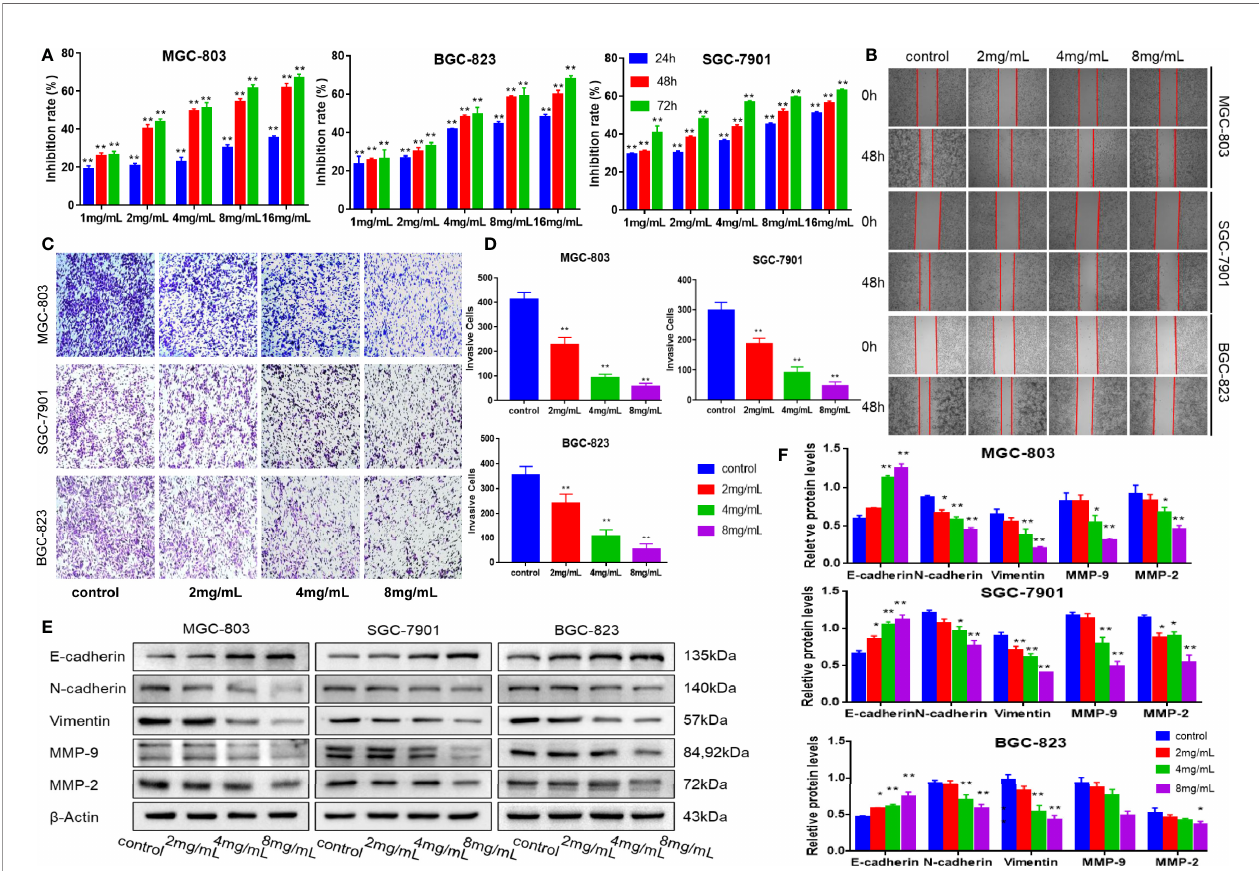
FIGURE 1 | mJPYZ inhibited the proliferation, migration and invasion of gastric cancer cells in vitro . (A) Viability of cancer cells interfered by mJPYZ was determined using the MTT assay. mJPYZ inhibited the GC cells proliferation in a dose- and time-dependent manner. (B) Migration of gastric cancer cells were detected by wound healing assay. The cell migration ability was decreased after mJPYZ treatment, and was positively correlated with the concentration of mJPYZ. (C, D) Invasion of gastric cancer cells were detected by Transwell invasion assay. The cell invasion ability was decreased after mJPYZ treatment, and was positively correlated with the concentration of mJPYZ. (E, F) Western blotting analysis of fundamental proteins related to EMT. mJPYZ treatment increased E-cadherin expression, while it decreased the expression of N-cadherin, Vimentin, MMP-9 and MMP-2 in a dose-dependent manner. Data are represented as mean ± SD, n=3 independent experiments. *P < 0.05, **P < 0.01 versus control group by one-way analysis of variance (ANOVA) followed by Tukey ’ s post-hoc